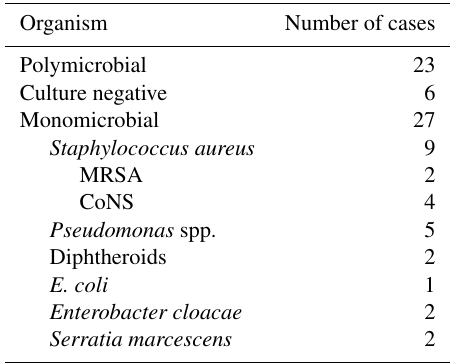
Table 3. Culture results of polymicrobial infections ( n = 23). Organism Number of cases Staphylococcus aureus 12 CoNS 9 2 4